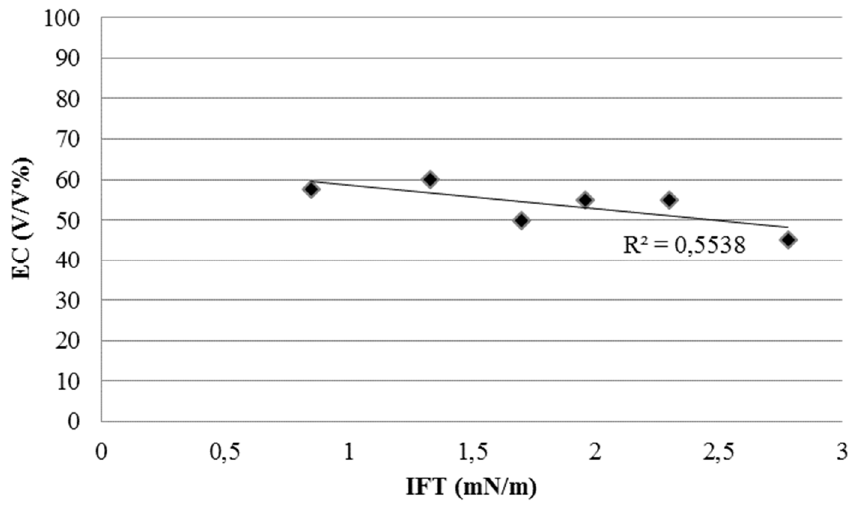
Figure 4. Emulsification capacity vs. IFT for surfactant mixtures from non ‐ ionic surfactants with different different structures.